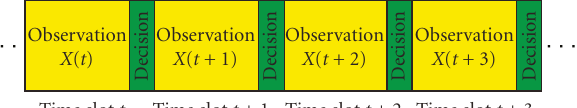
Figure 2: Timing structure of the spectrum